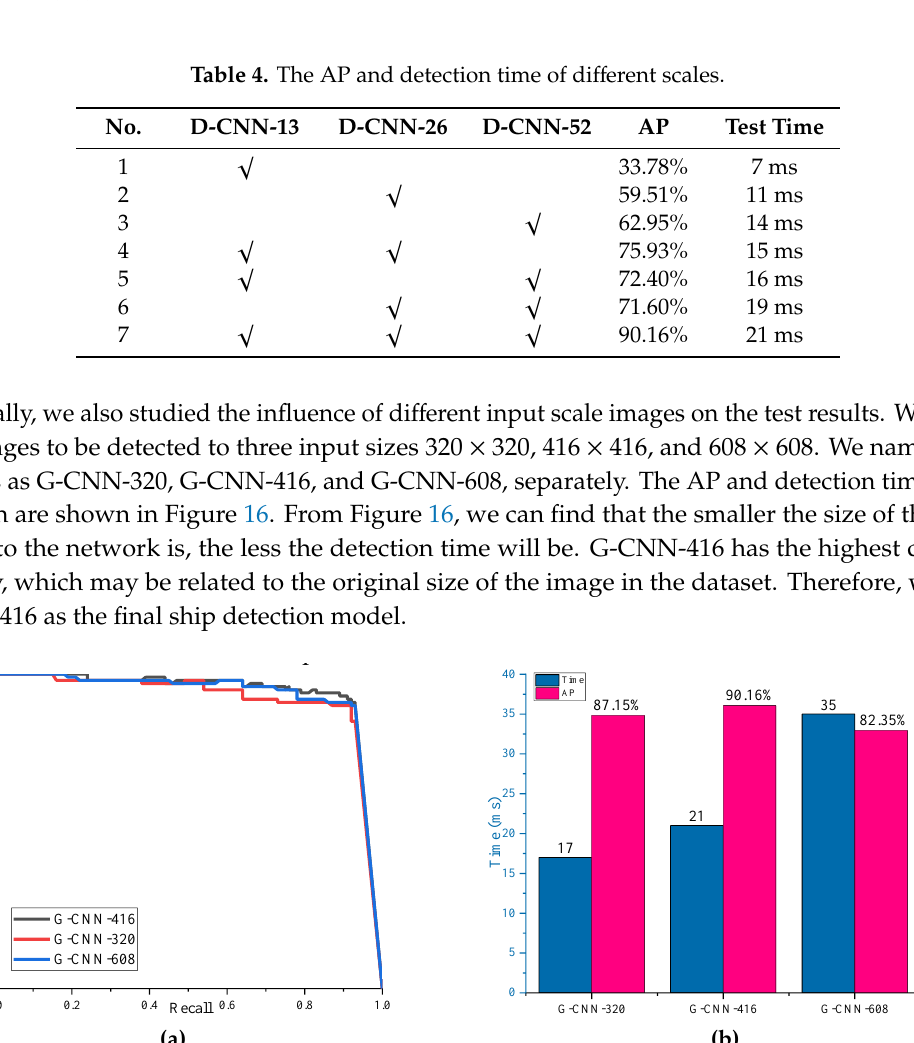
scales to detect ships. The AP and detection time of different scales are shown in Table 4. From Table